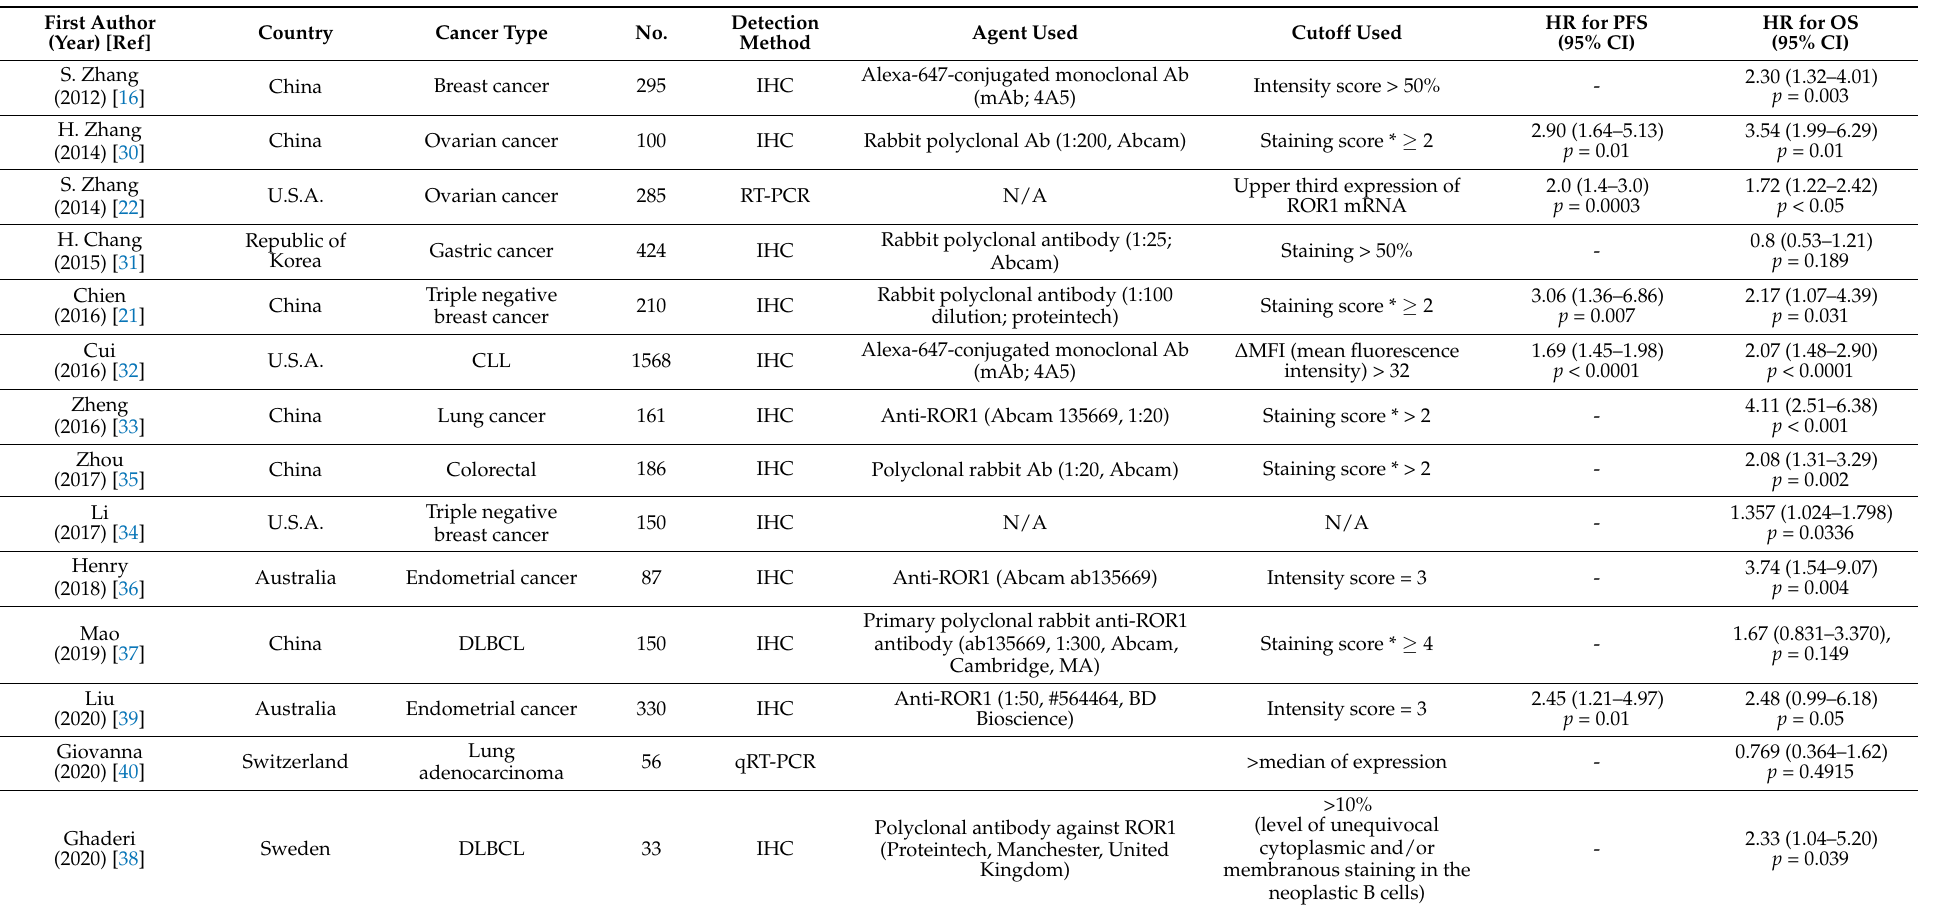
Table 1. Characteristics included for the study of